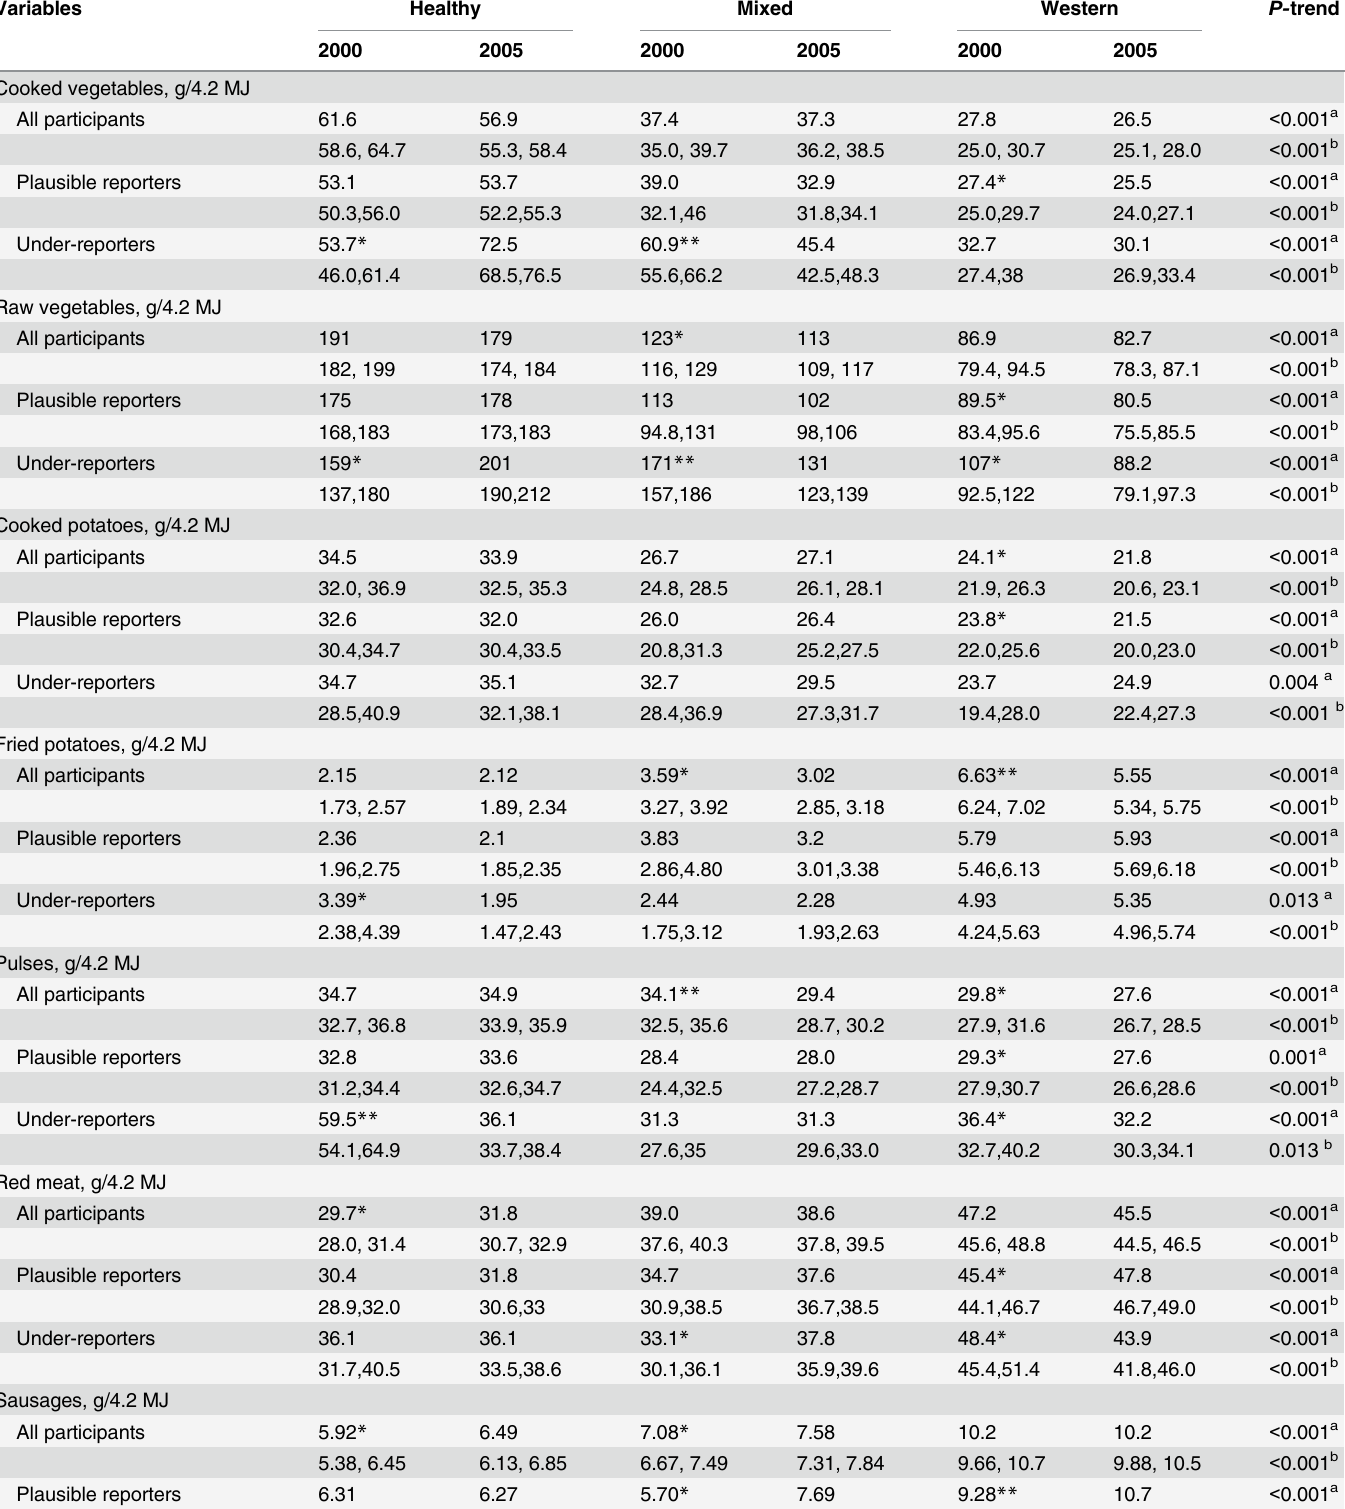
Table 2. Characteristics of food groups and nutrients according to clusters of surveys in 2000 and